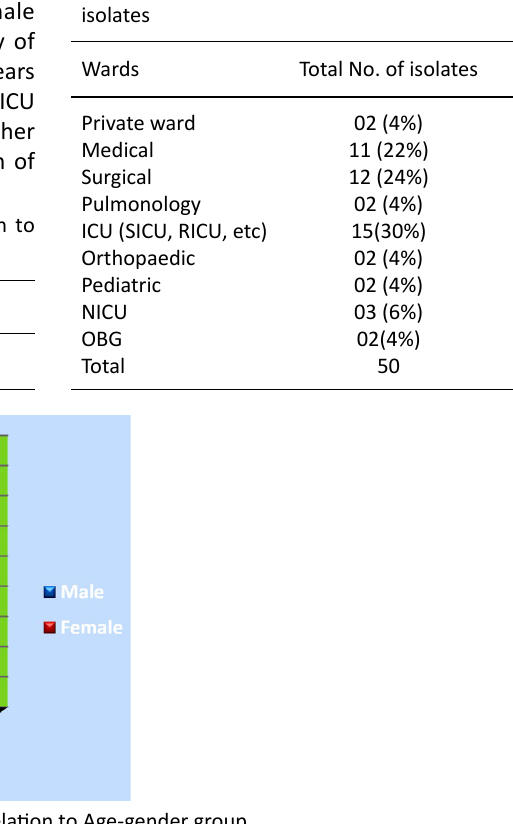
Table 3. Ward wise distribution of MDR Acinetobacter